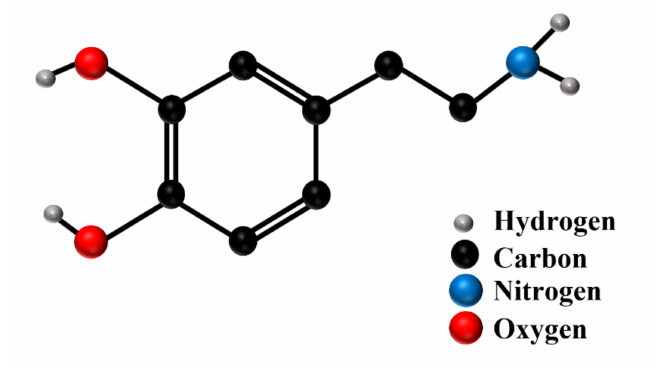
Figure 1. Structure of a dopamine